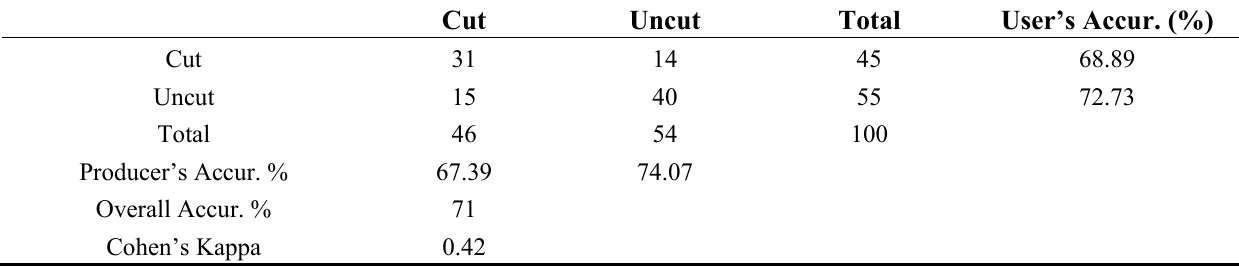
Table 3. Confusion matrix and accuracies of raw NDVI data set (30 April to 5 September).